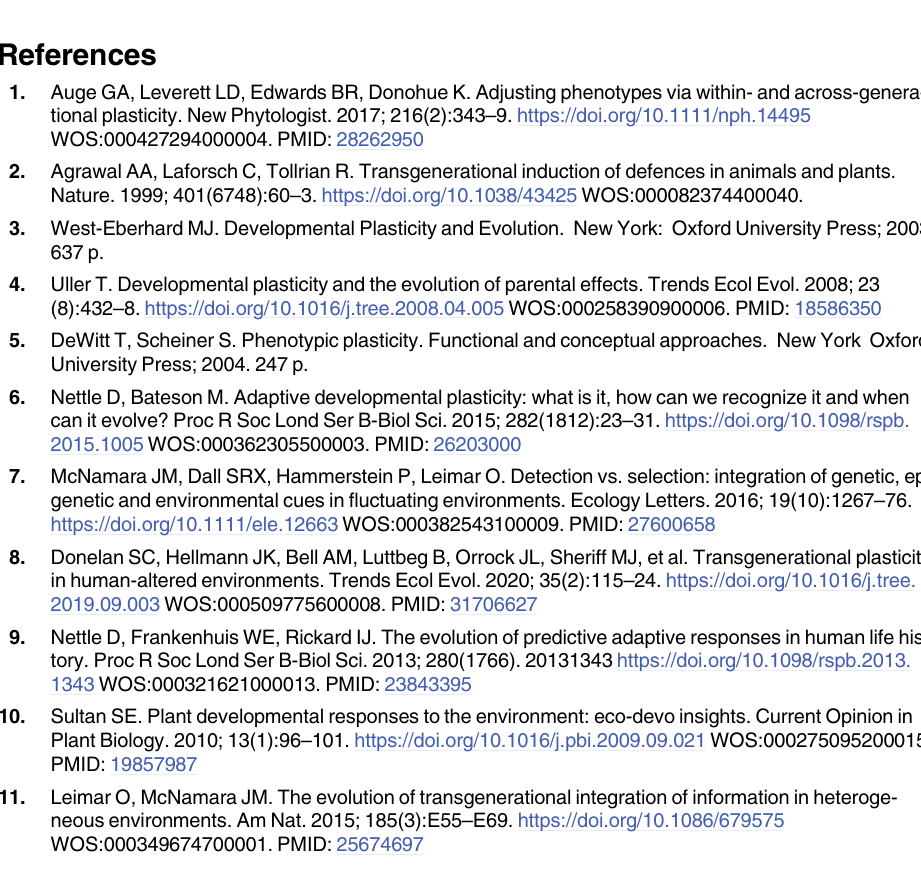
S1 Fig. Parental prior distributions. S2 Fig. Cumulative likelihood